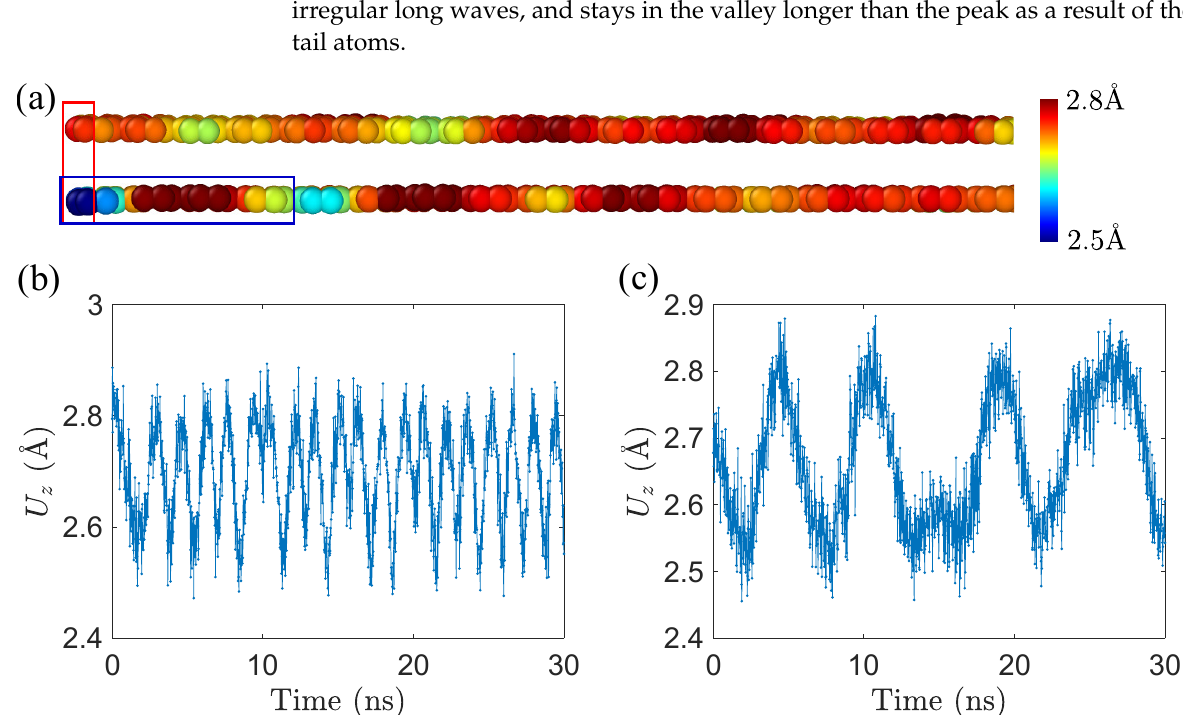
Figure 6. The sinking of tail atoms. ( a ) two morphologies of tail atoms in GNRs under horizontal drag. The upper one is in the sliding process, while the lower one is in the peeling process. The color bar shows the distance from the substrate. We compute the LJ potential energy of atoms in the blue box that forms a moiré pattern. ( b , c ) variations of U z of tail atom in a GNR with l x ∼ 20 nm. ( b ) v d = 0.2 m/s and Z 0 = 10 Å, sliding behavior; ( c ) v d = 0.4 m/s and Z 0 = 17.5 Å, peeling